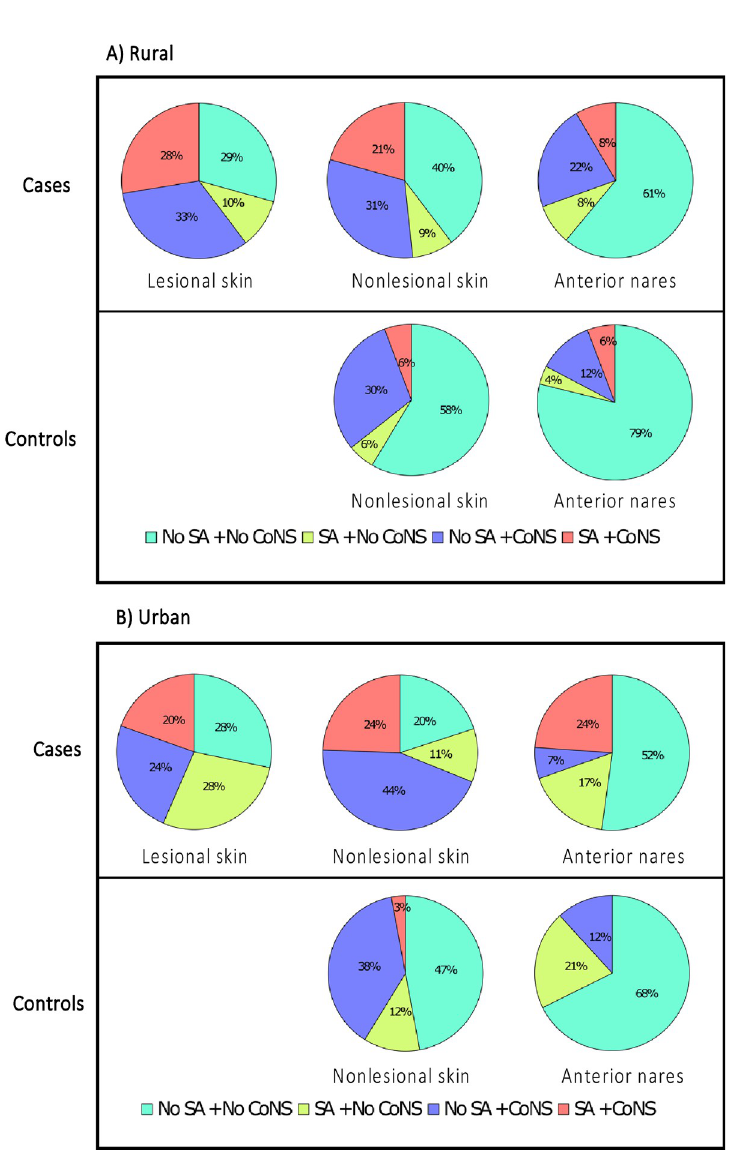
Fig 2. The distribution of S . aureus and CoNS colonization on the lesional, nonlesional skin, and anterior nares of (A) rural and (B) urban cases and controls. CoNS colonization is defined as the carriage of at least one CoNS species. SA, S . aureus ; CoNS, coagulase-negative staphylococci. sampling sites revealed a higher colonization prevalence of S . hominis in the nonlesional skin than lesional skin ( P = 0.016) and anterior nares ( P = 0.0004) in urban cases. This trend was also observed with S . capitis nonlesional skin colonization compared to anterior nares ( P = 0.027) but not AD lesional skin ( P = 0.069) among urban cases.